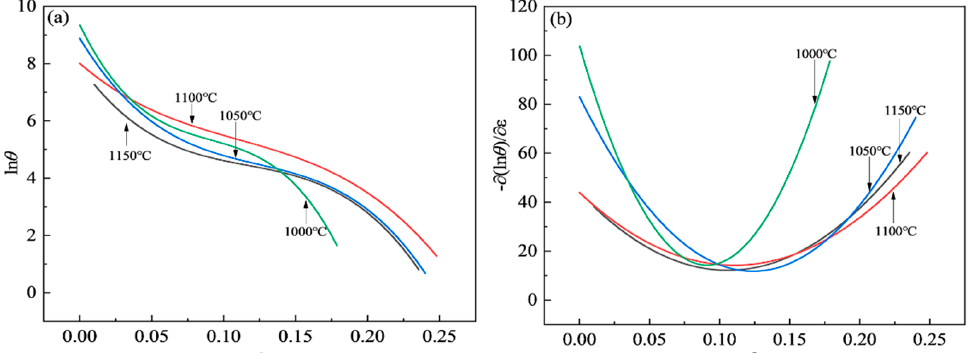
Figure 10. Relationship between ln θ − ε and − ∂ ( ln θ ) / ∂ε − ε for S280 steel at a strain rate of 0.01 s − 1 Figure 10. Relationship between ln𝜃– 𝜀 and − ∂(ln𝜃)/𝜕𝜀 − 𝜀 for S280 steel at a strain rate of 0.01 s − 1 Figure 10. Relationship between ln𝜃– 𝜀 and − ∂(ln𝜃)/𝜕𝜀 − 𝜀 for S280 steel at a strain rate of 0.01 s − 1 Figure 10. Relationship between ln𝜃– 𝜀 and − ∂(ln𝜃)/𝜕𝜀 − 𝜀 for S280 steel at a strain rate of 0.01 s − 1 and different deformation temperatures: ( a ) ln𝜃– 𝜀; (𝒃) − 𝜕(ln𝜃)/𝜕𝜀 − 𝜀 . and different deformation temperatures: ( a ) ln θ − ε ; ( b ) − ∂ ( ln θ ) / ∂ε − ε . and different deformation temperatures: ( a ) ln𝜃– 𝜀; (𝒃) − 𝜕(ln𝜃)/𝜕𝜀 − 𝜀 . and different deformation temperatures: ( a ) ln𝜃– 𝜀; (𝒃) − 𝜕(ln𝜃)/𝜕𝜀 − 𝜀 .